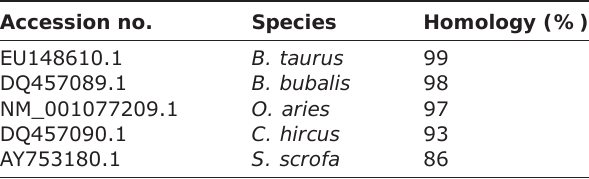
Table-4: Identity of CD14 gene of KF ( B. indicus×Bos taurus ) with other